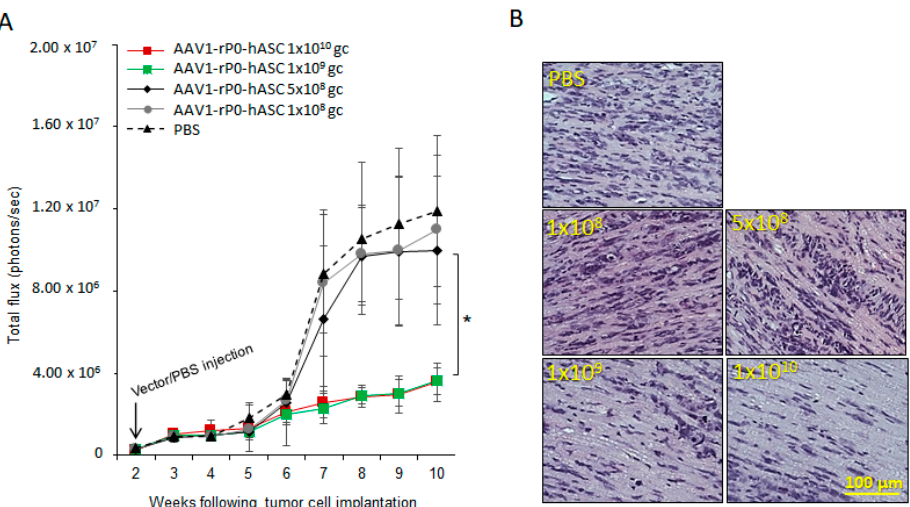
Figure 1. Determination of the minimum effective dose (MED) of AAV1-rP0-hASC control of HEI- 193 intrasciatic schwannomas. ( A ) Growth kinetics of intrasciatic HEI-193 xenograft schwannomas following intra-tumoral (I.T.) with different doses of AAV1-rP0-hASC or PBS control ( n = 8 per group). ANOVA indicated a significant effect of 1 × 10 10 gc and 1 × 10 9 gc AAV1-rP0-hASC compared to PBS, but not of 5 × 10 8 gc or 1 × 10 8 gc AAV1-rP0-hASC (* p < 0.05). ( B ) Hematoxylin and eosin (H&E) staining demonstrated abundant, mitotically active hematoxylin-positive HEI-193 tumor cells in the mice which experimental schwannomas were injected I.T. with 5 × 10 8 gc and 1 × 10 8 gc of AAV1-rP0-hASC or PBS, but fewer tumor cells were in tumor-bearing nerves injected with 1 × 10 10 gc and 1 × 10 9 gc AAV1-rP0-hASC.